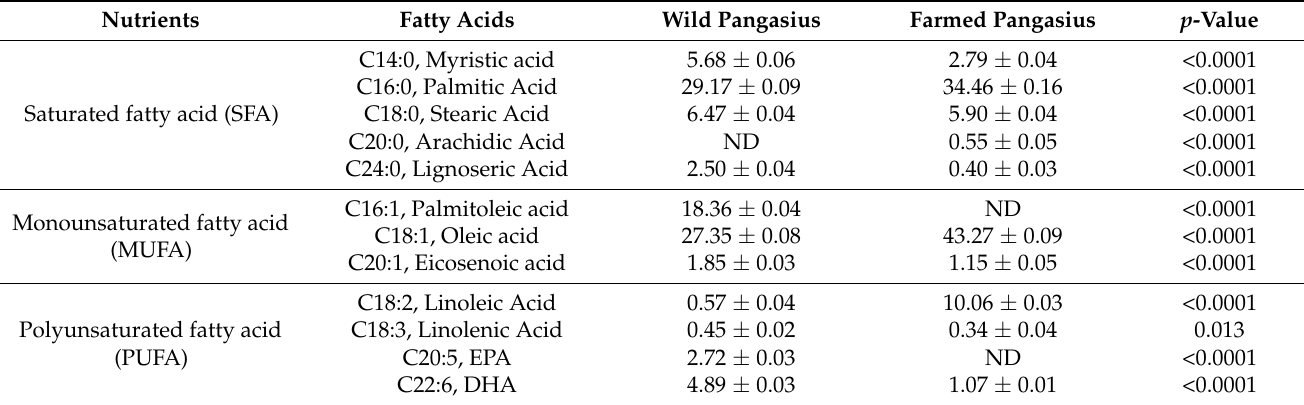
Table 4. Comparison of the fatty acids compositions (g/100 g of total fatty acids; wet basis) of wild and farmed pangasius